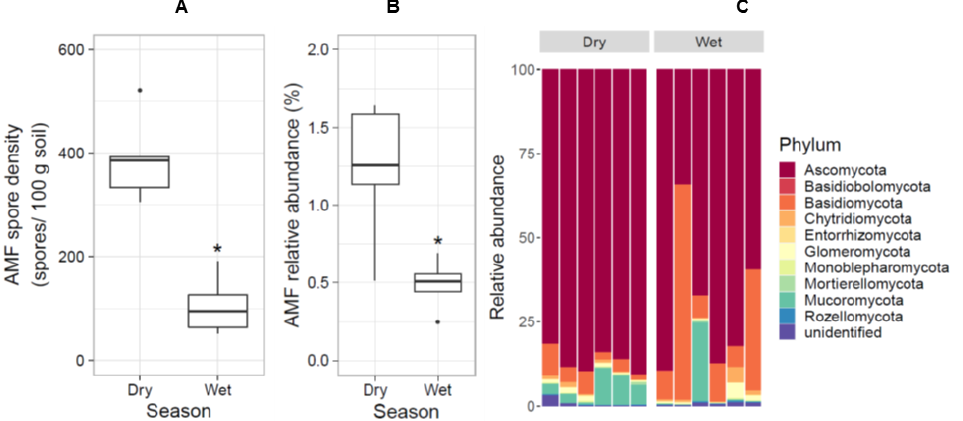
Figure 2. Changes in AMF spore densities and AMF relative abundance between the dry and wet seasons. The box plots show the distribution of AMF spore densities ( A ) and AMF relative abundance ( B ) in soil in the dry and wet seasons ( n = 6 biological replicates). Fungal relative abundances in soil between dry and wet seasons were determined by analysing ITS2 regions ( C ). Statistical analysis was performed by Student’s t -test. Asterisks indicate significant differences ( p < 0.05).